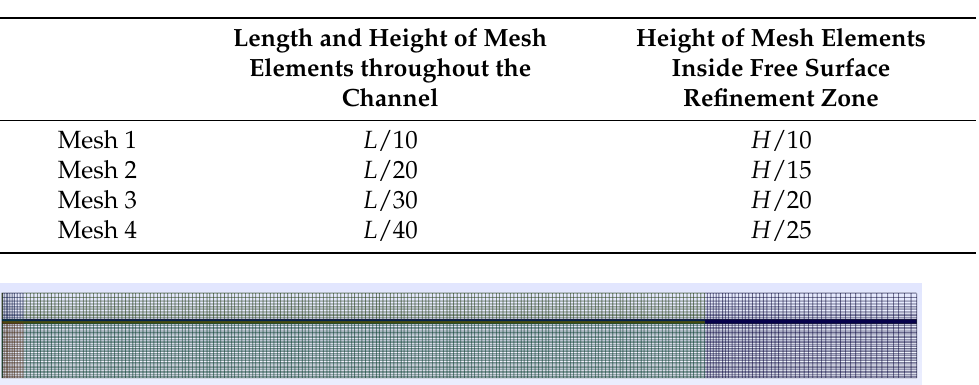
Figure 5. Two-dimensional mesh used in this study for wave generation